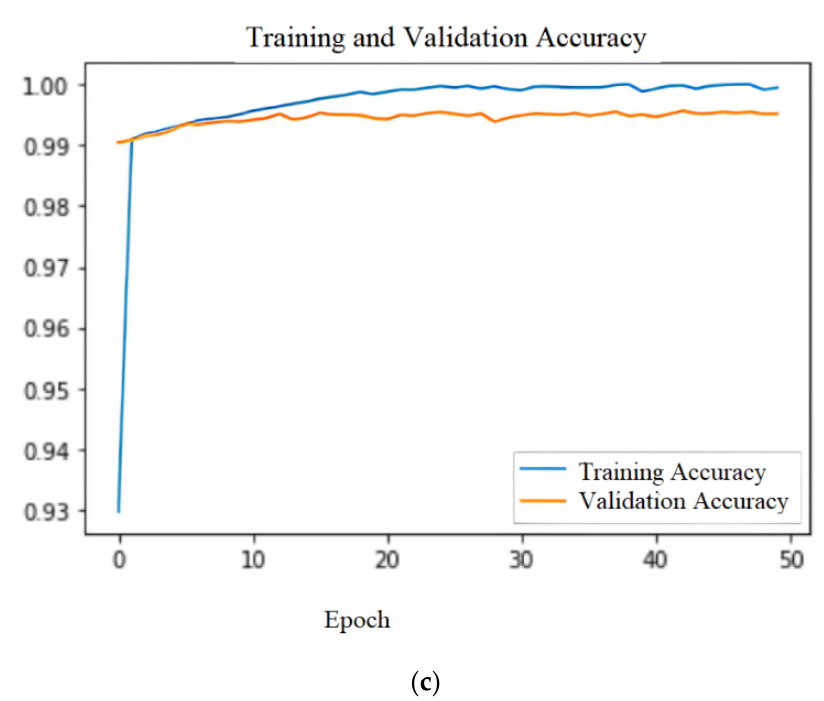
Figure 7. ( a ) Training and validation accuracy for LSTM model. ( b ). Training and validation accuracy for Bi-LSTM model. ( c ). Training and validation accuracy for GRN-based RNN algorithm. The blue curves in Figure 7a – c indicate the training accuracy and the orange curves describe the validation accuracy. In Figure 8a – c, the blue curve indicates the training loss for all the methods and the orange curve describes the validation loss. In Figure 8, the x -axis indicates the number of epochs, and the y -axis represents the loss. Table 2 shows the training accuracy achieved using the LSTM, Bi-LSTM, and GRU networks.